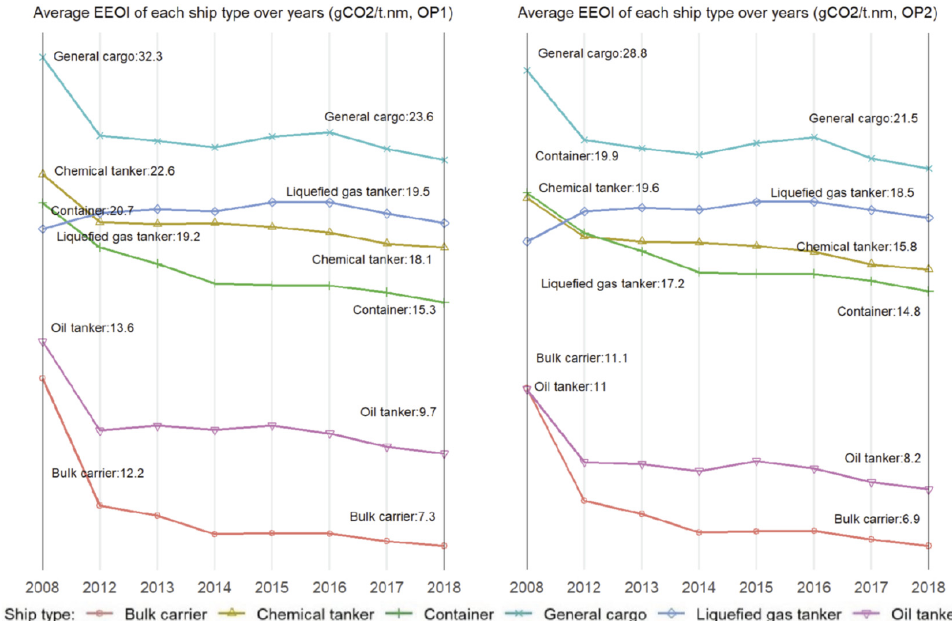
Figure 2. Average annual carbon intensity of individual ship types (2008–2018). Source: IMO Fourth GHG Study [3]. Note: ‘OP1 ′ and ‘OP2 ′ are the two alternative estimation methods; vessel-based in the case of OP1 and voyage-based in the case of OP2.